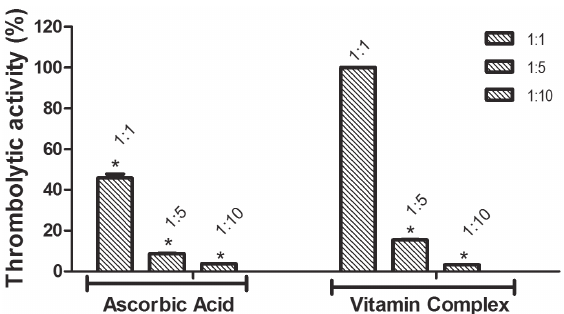
Figure 3 - Vitamins effect on thrombolytic activity induced by Bothrops atrox venom. The controls average containing only venom was considered as 100%